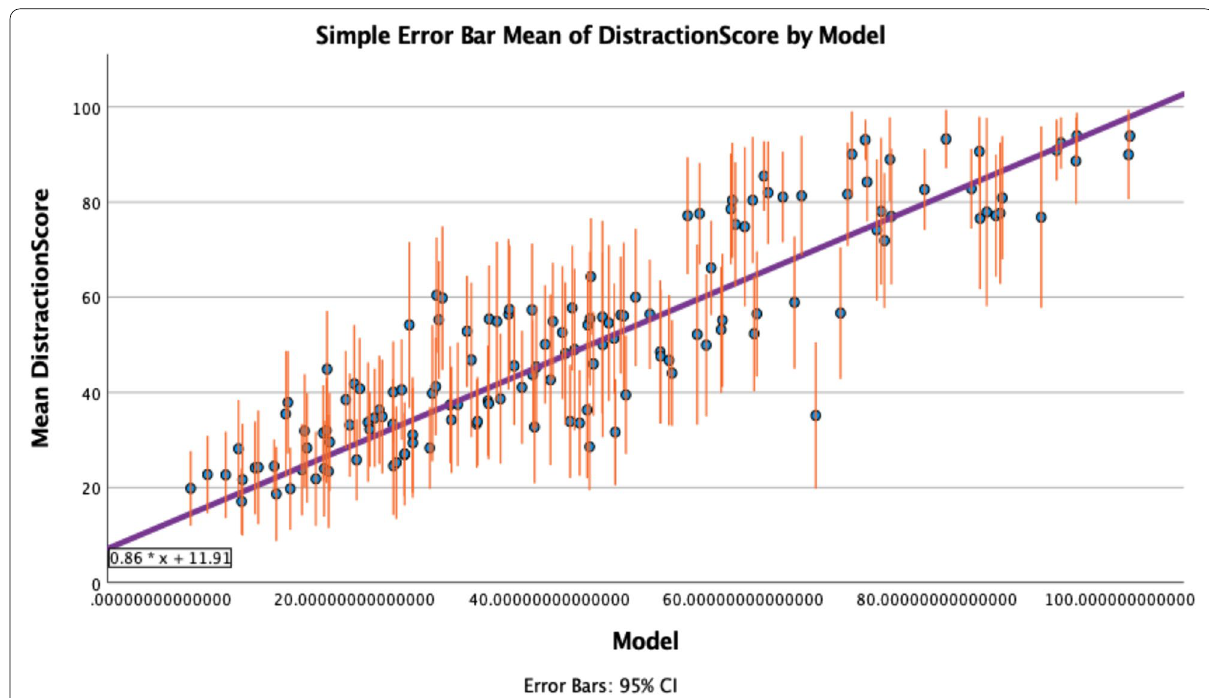
Fig. 5 Error Bar of the Distraction Score with the Distraction model. The fit line is also visible, indicating that there is a linear correlation between the distraction ratings and distraction